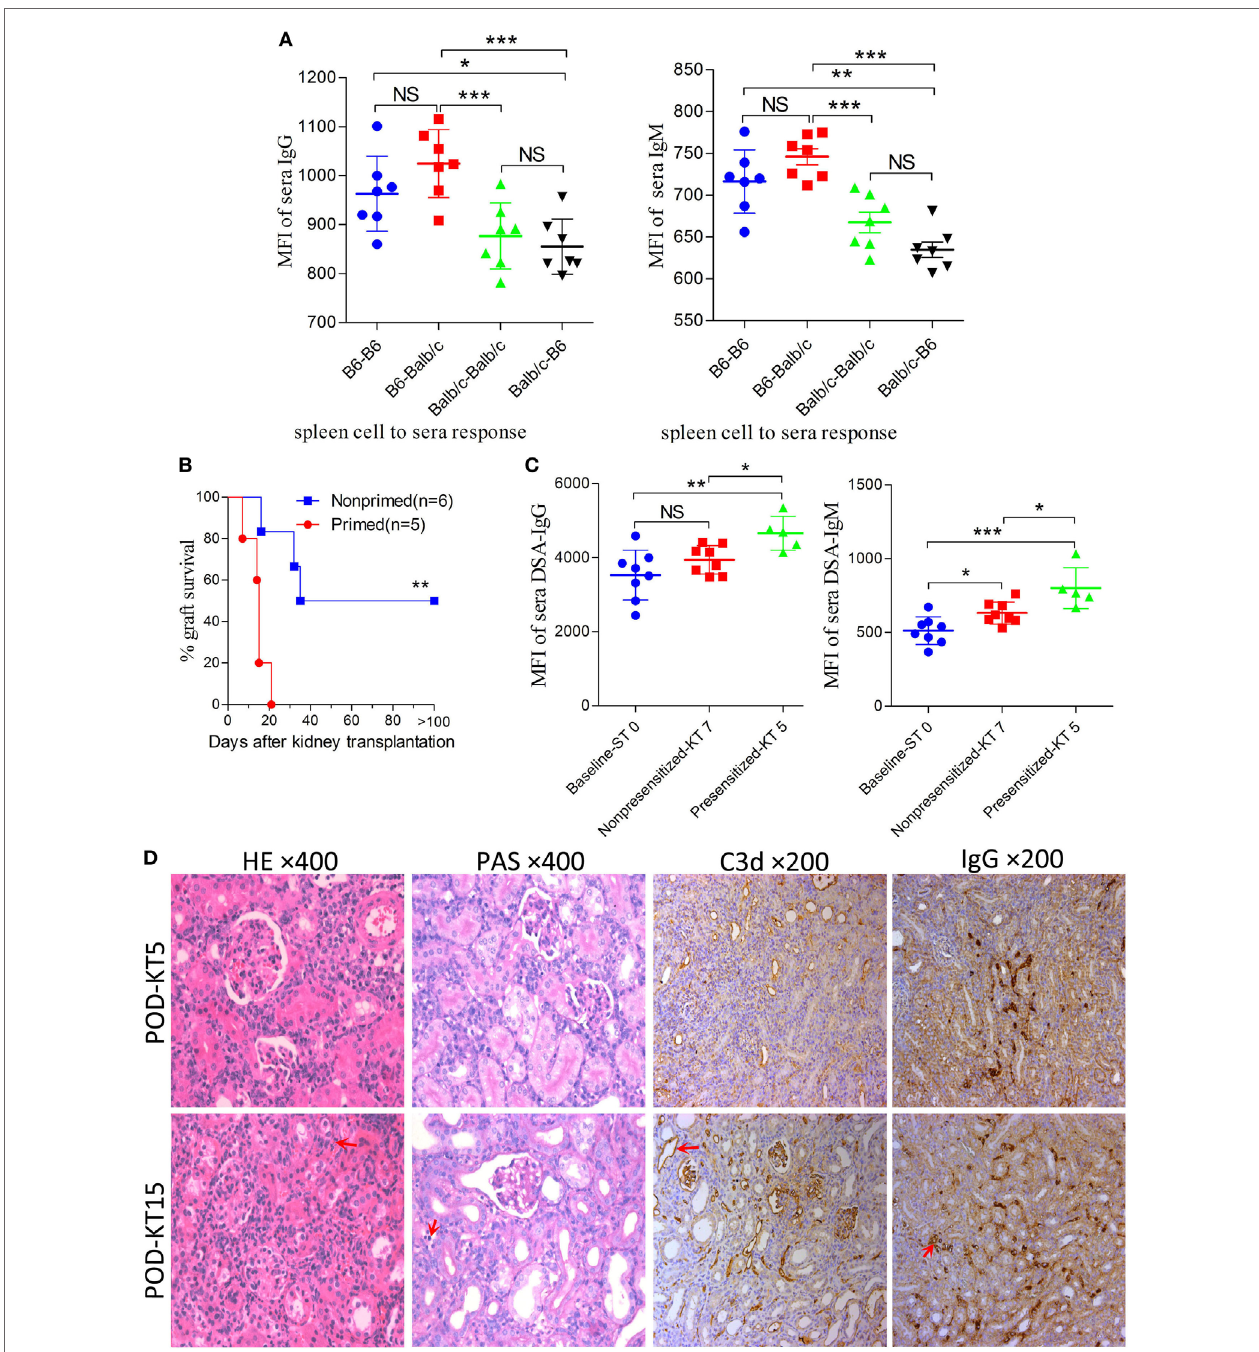
FigUre 4 | Improving survival by establishing an antibody-mediated rejection (AMR) model in C57BL/6 to Balb/c mice. Balb/c recipient mice were primed with C57BL/6 skin grafts for 4 days prior to receiving C57BL/6 kidney grafts. Balb/c mice receiving C57BL/6 kidneys without skin grafting acted as the nonprimed controls. Serum donor-specific antibody (DSA) levels were detected by flow cytometry and expressed as mean fluorescence intensity (MFI). The DSA data represent mean ± SD of at least five independent samples (Student’s t -test). ST0 = day 0 before skin transplant, KT5, KT7, and KT15 = day 5, 7, and 15 after kidney transplant, respectively. * P < 0.05, ** P < 0.01, *** P < 0.001. NS, no significant difference. (a) Donor-reactive antibody baseline levels in C57BL/6-Balb/c were higher than those in Balb/c-C57BL/6. (b) Kidney graft mean ± SD survival times were > 33.8 ± 9.3 and 14.4 ± 5.0 days in the nonprimed and primed groups, respectively (Log-rank test). (c) DSA levels of IgG and IgM in the sera from recipients in the primed group were significantly increased on KT5 compared to the baseline ST0, and were higher than the levels on KT7 in the nonprimed group. (D) Sections of kidney grafts were stained with hematoxylin and eosin (H&E) and periodic acid-Schiff (PAS), × 400; and for the deposition of IgG and C3d, × 200. AMR histological features of tubular injury, peritubular capillary (PTC) dilation, and capillaritis, deposition of IgG and C3d in PTC could be identified on KT5 and KT15 in the skin-primed group. Arrows in the HE and PAS staining indicate the PTC and capillaritis. Arrows in the IgG and C3d staining indicate the positive depositions in